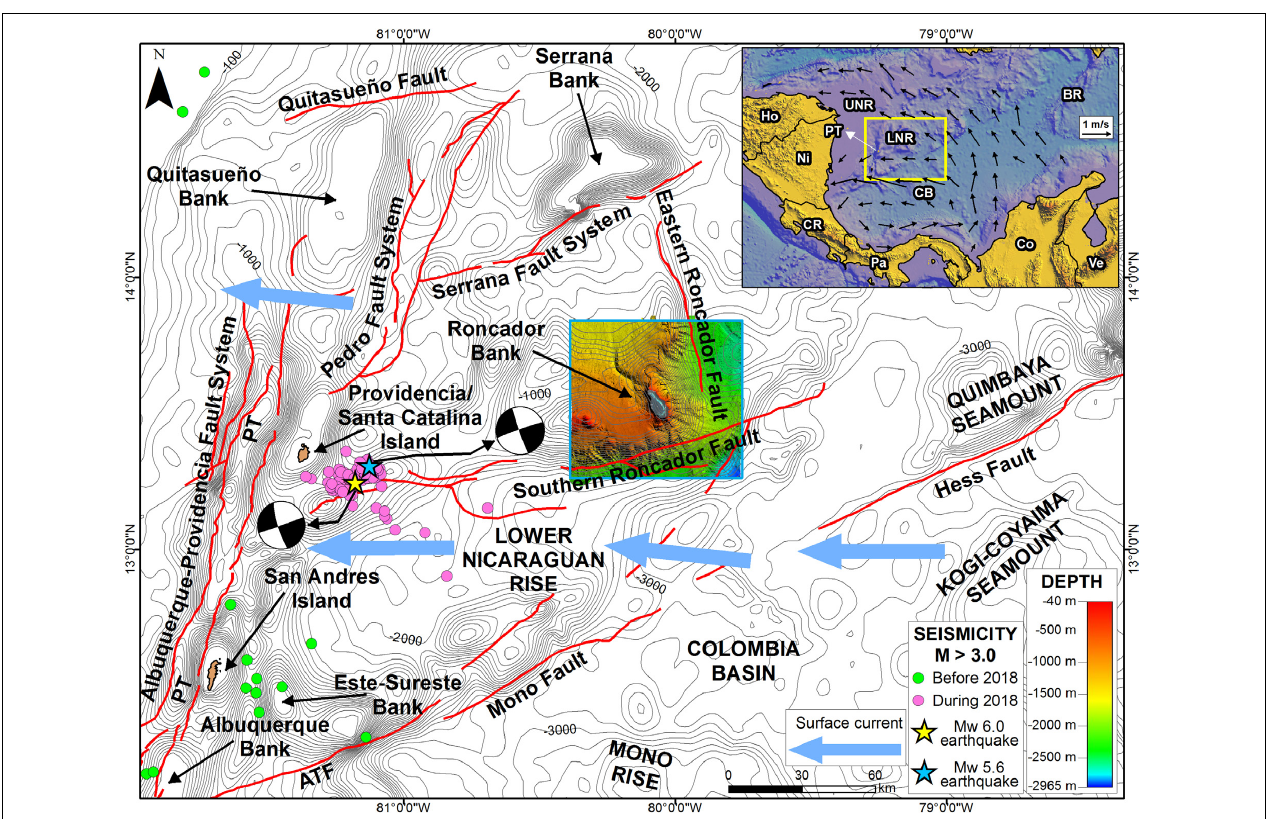
FIGURE 1 | Location of Roncador Bank in the Archipelago of San Andres, Providencia and Santa Catalina (ASAPSC) as indicated by the DTM in the blue box. The regional fault systems are shown as red lines and the instrumental seismicity (M > 3) is indicated by green and pink circles. The blue and yellow starts correspond to the Mw 5.6 and Mw 6.0 earthquakes occurred in 2018 with their focal mechanisms as reported by the Colombia National Seismological Network. The flow of surface currents (Caribbean current) around Roncador is represented by the thick blue arrows (Coralina-Invemar, 2012). The isobaths spacing is 100 m. The inset in the upper right corner shows the location of the ASAPSC area in western Caribbean, where the directions of the Caribbean surface current are indicated by the thin black arrows (Coralina-Invemar, 2012). PT, Providencia Trough; ATF, Albuquerque-Turmeque Fault; LNR, Lower Nicaraguan Rise; UNR, Upper Nicaraguan Rise; BR, Beata Ridge; CB, Colombia Basin; Ho, Honduras; Ni, Nicaragua; CR, Costa Rica; Pa, Panama; Co, Colombia; Ve,